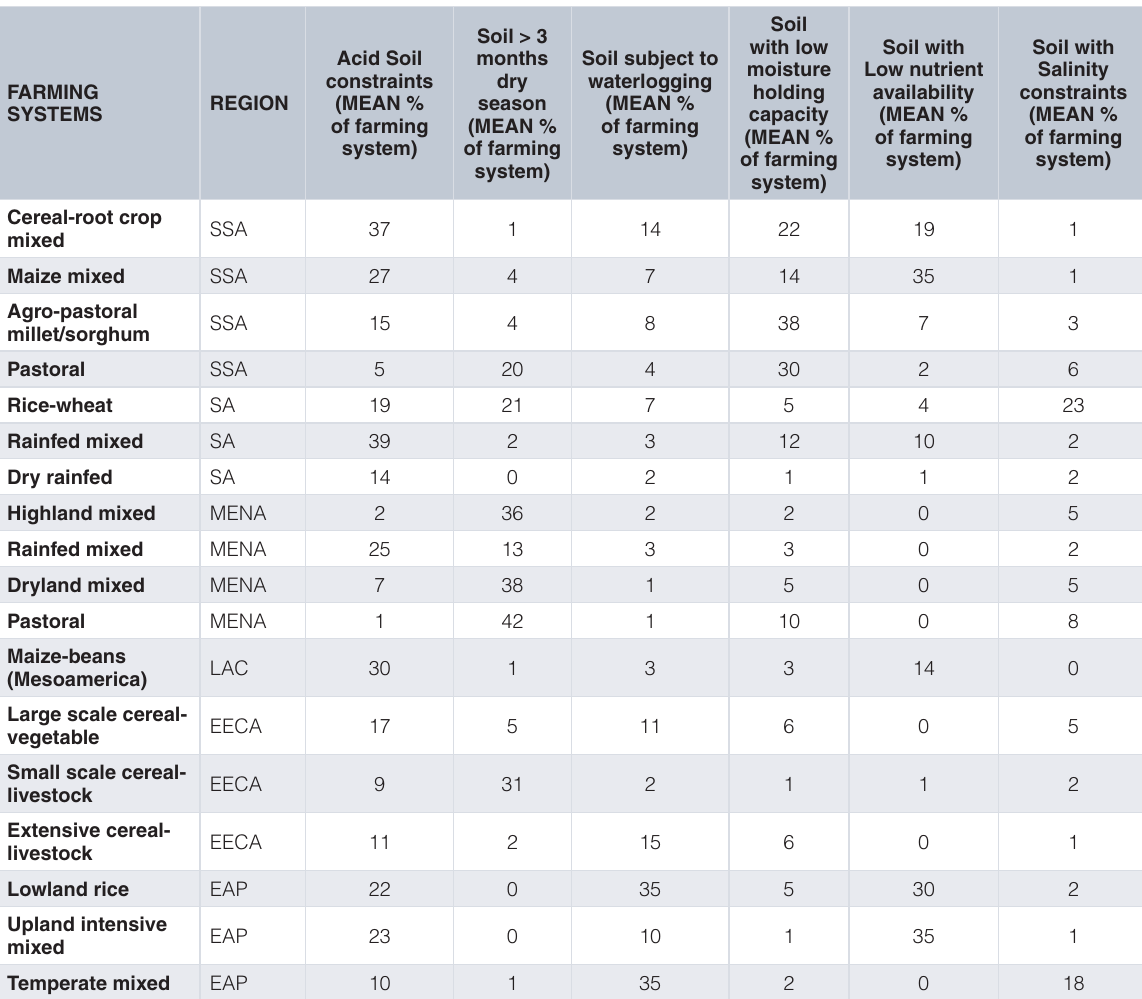
Table 6. The percentage area of each of the 18 priority farming system with soil constraints.